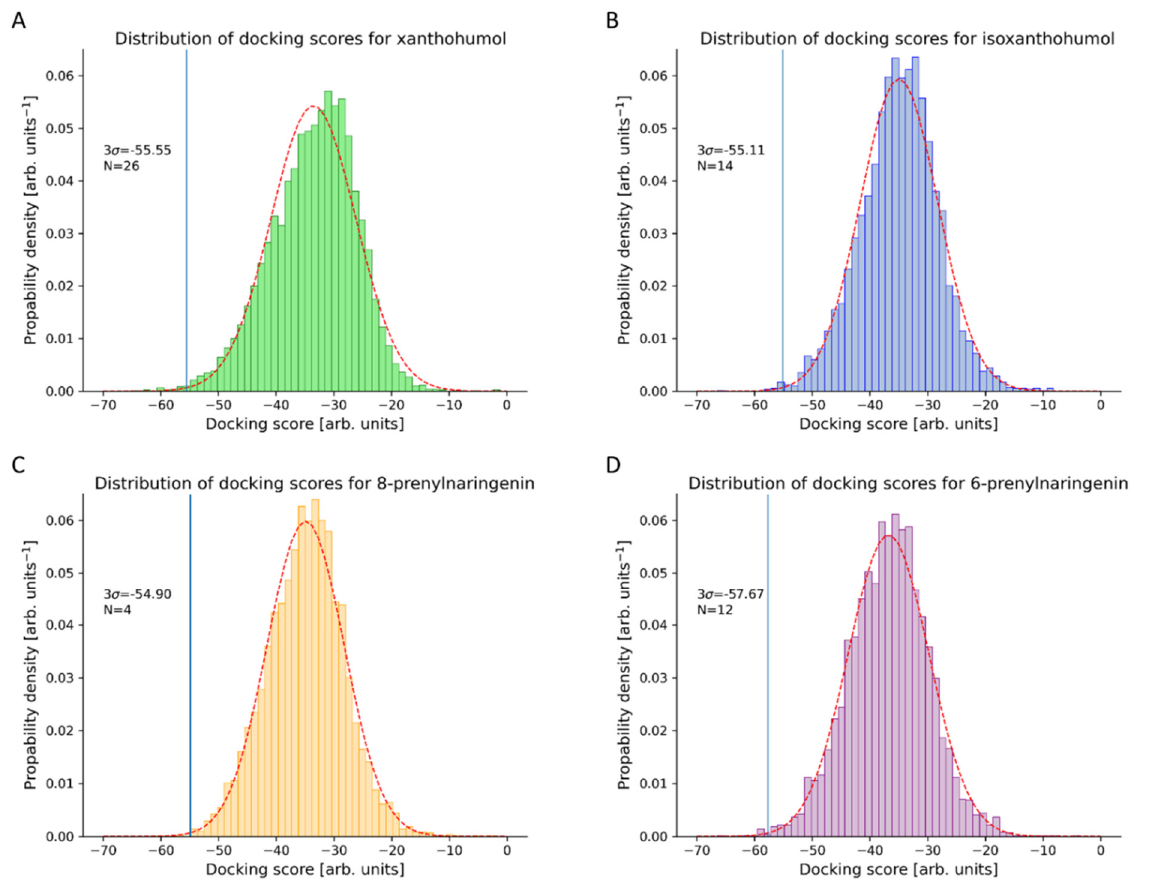
Figure 3. Normal distribution fitting graphs of inverse docking scores for xanthohumol, isoxanthohumol, 8-prenylnaringenin, and 6-prenylnaringenin. 3 σ is the designation for 99.7% confidence interval, and the N represents the number of proteins that fit these preselected criteria.